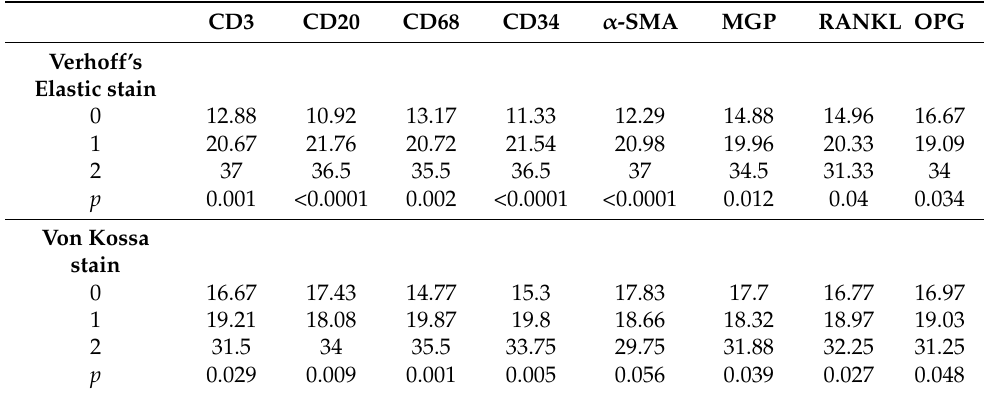
Table 5. Differences on the expression of CD3(+), CD20(+), CD68(+), a-SMA(+) cells, and MGP, RANKL, and OPG according to the severity of radial artery